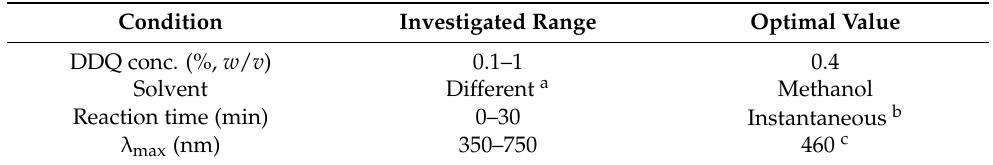
Figure 2. The e ff ect of 2,3-dichloro-3,5-dicyano-1,4-benzoquinone (DDQ) concentration on charge Figure 2. The effect of 2,3-dichloro-3,5-dicyano-1,4-benzoquinone (DDQ) concentration on charge transfer (CT) reaction with LOR (6.15 × 10 − 4 M, in methanol). transfer (CT) reaction with LOR (6.15 × 10 − 4 M, in methanol). Table 1. Optimization of MW-SPA experimental conditions. Table 1. Optimization of MW-SPA experimental conditions.